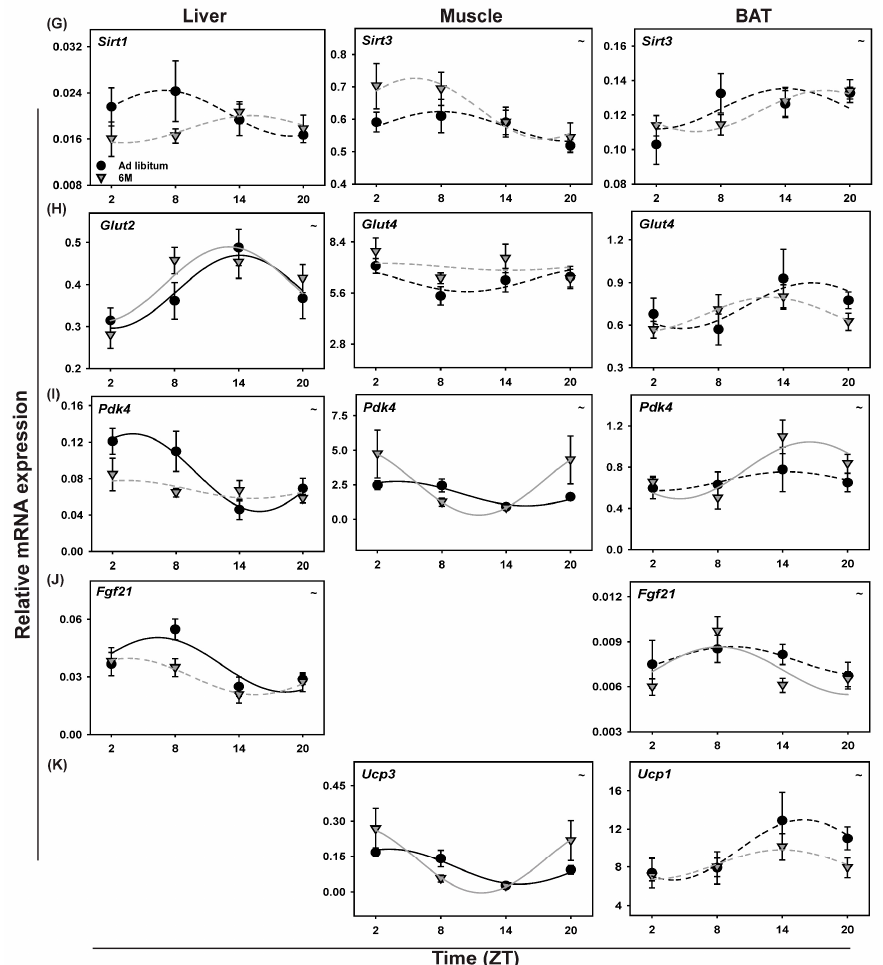
Figure 6. Daily profiles of metabolic gene expression in Liver, Muscle and BAT in animals fed ad libitum (Black circles) or according the 6-meals-a-day feeding schedule (Gray triangles). ( A ) Srebp1c, ( B ) Hsl, ( C ) Lpl, ( D ) Fas, ( E ) Pgc-1 α , ( F ) Ppar α , ( G ) Sirt1 and Sirt3, ( H ) Glut2 and Glut4, ( I ) Pdk4, ( J ) Fgf21 and ( K ) Ucp1 and Ucp3. Fitted lines show significant cosine regressions (see methods). ~= effect of Time ( p <